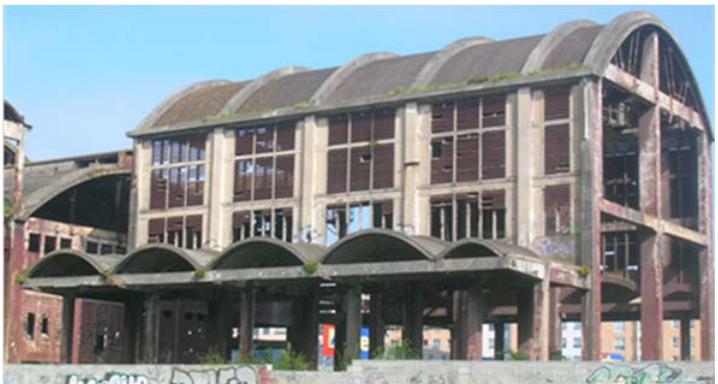
Figure 1. Condition of the industrial building before transformation (photo courtesy of Diaz & Diaz Architects S.L.).